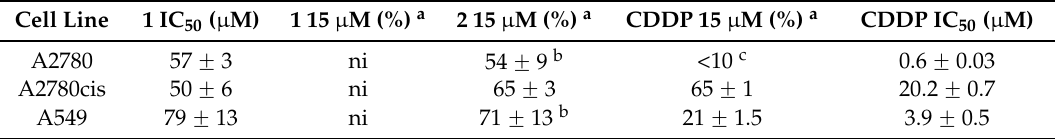
Table 4. Cytotoxic activity of 1 , 2 and cisplatin (CDDP) towards human cancer cell lines. Cell